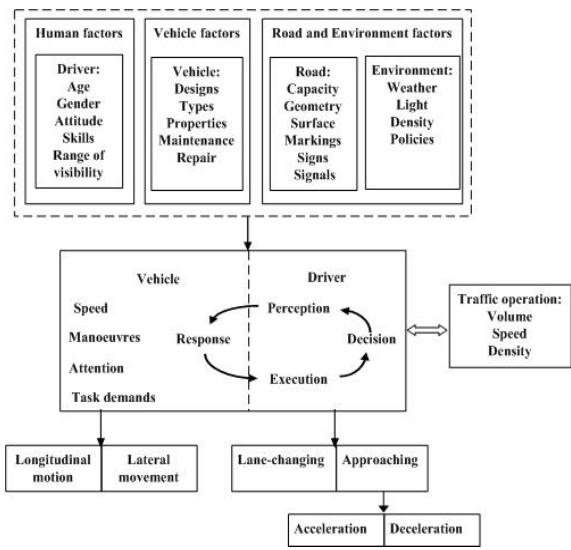
Fig.1. Drivers, vehicles, roads and environments